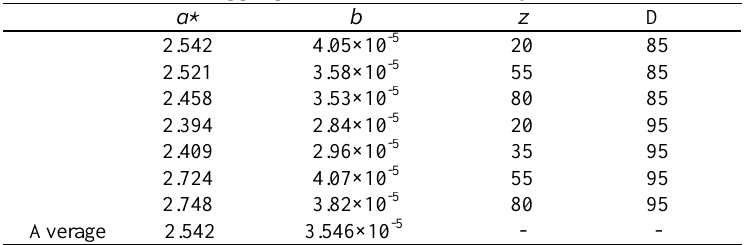
Table 11. a and b coefficients used in calculation of the gradient based on the equation (6) for the aggregates tested in this